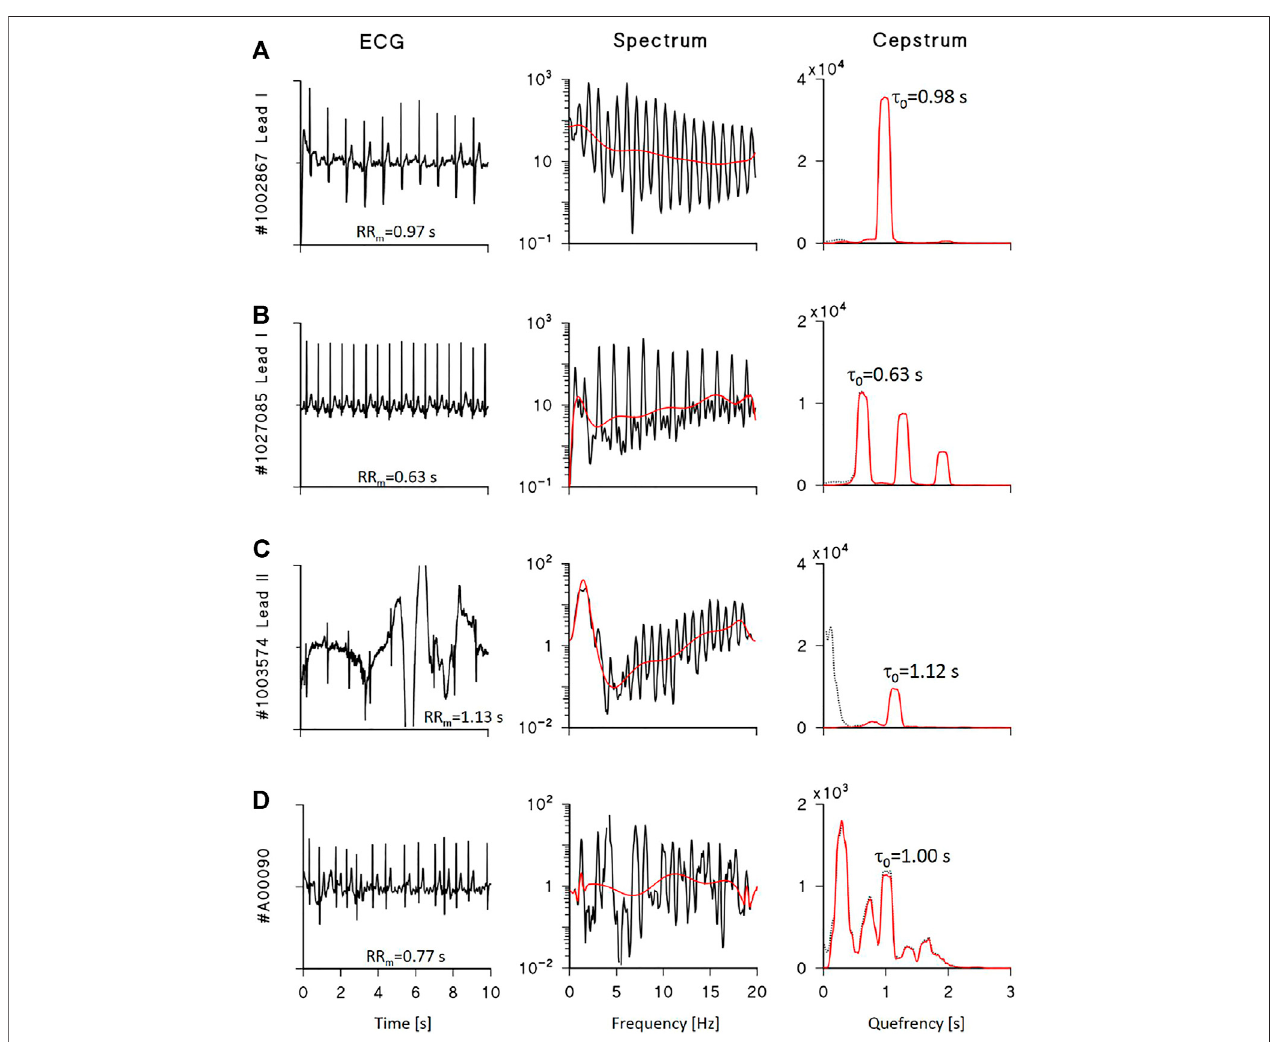
FIGURE 3 | Examples of ECG cepstral analysis. Left : 10-s ECG segments from the Physionet/Computing in Cardiology datasets of the 2011 (A – C) and 2017 (D) Challenges; centre : log-spectra with polynomial trends (red line); right : cepstra before (dotted black) and after (red) liftering by polynomial detrending, with τ 0 the quefrencyoftheestimated fi rstharmonic. (A) showsahighqualityECGandacepstrumwithasingleharmonic;thecorrespondingCQIis91.1%. (B) showsahighquality ECG, its cepstrum with 3 harmonics multiple of τ 0 , and CQI is 67.2%. (C) shows a low-quality ECG with a single harmonic identi fi able in the liftered cepstrum and CQI is 29.3% due to consistent low-quefrency noise. (D) shows a high quality ECG during atrial fi brillation: the log-spectrum does not have a periodic structure, the liftered cepstrum does not show a clear fi rst harmonic, and CQI is 22.1% only. When a clear cepstral fi rst harmonic is identi fi able (A – C) , its quefrency τ 0 practically coincides with the mean R-R interval, RR m